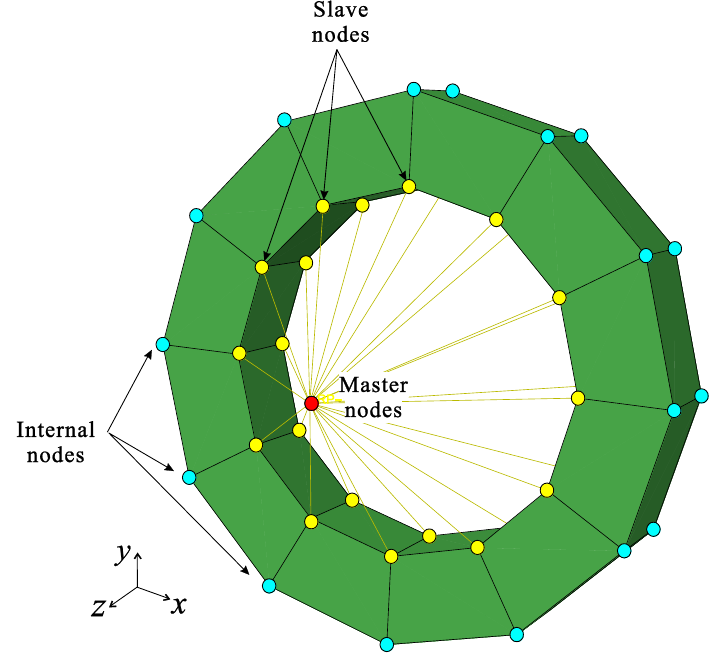
Figure 4. One rigid body element (RBE), where the red dot represents a master node, yellow dots represent slave nodes, and blue dots represent internal nodes.